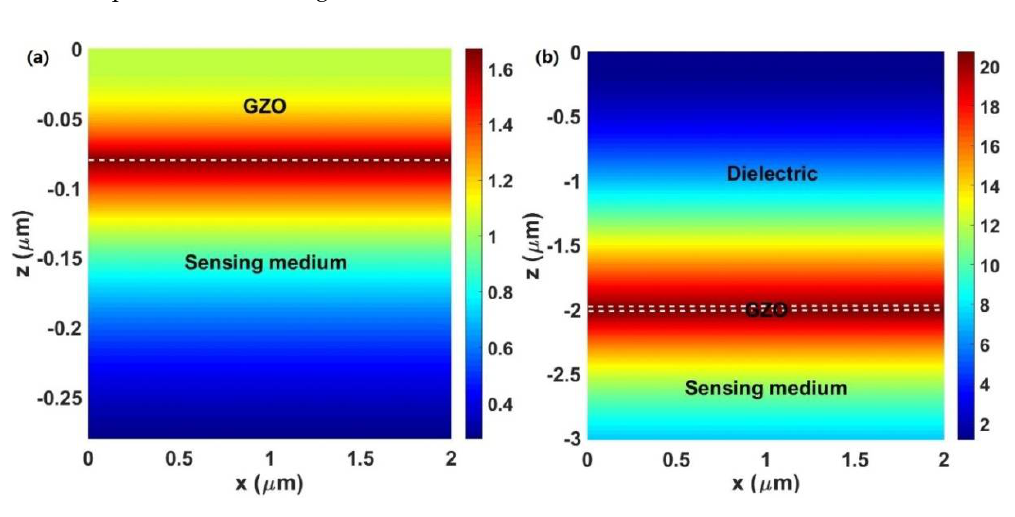
Figure 3. ( a ) The electric field distributions for an SPR sensor based on the 80 nm thick GZO; ( b ) the electric field distributions for a GZO-based LRSPR sensor with d D = 2000 nm, d G = 18 nm.